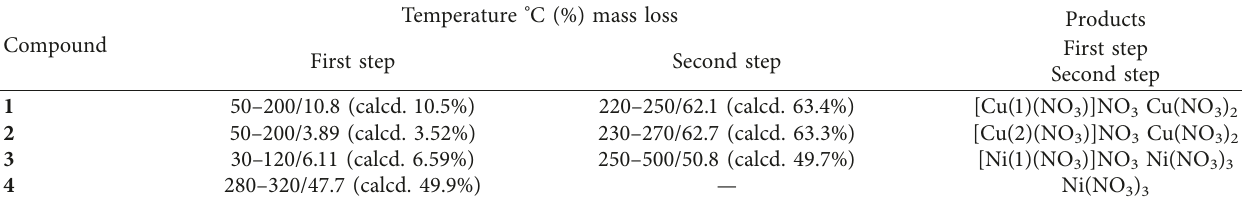
Table 4: Experimental values of the temperature and percentage of mass loss observed in each step of the TG-DTG curves in an inert atmosphere.